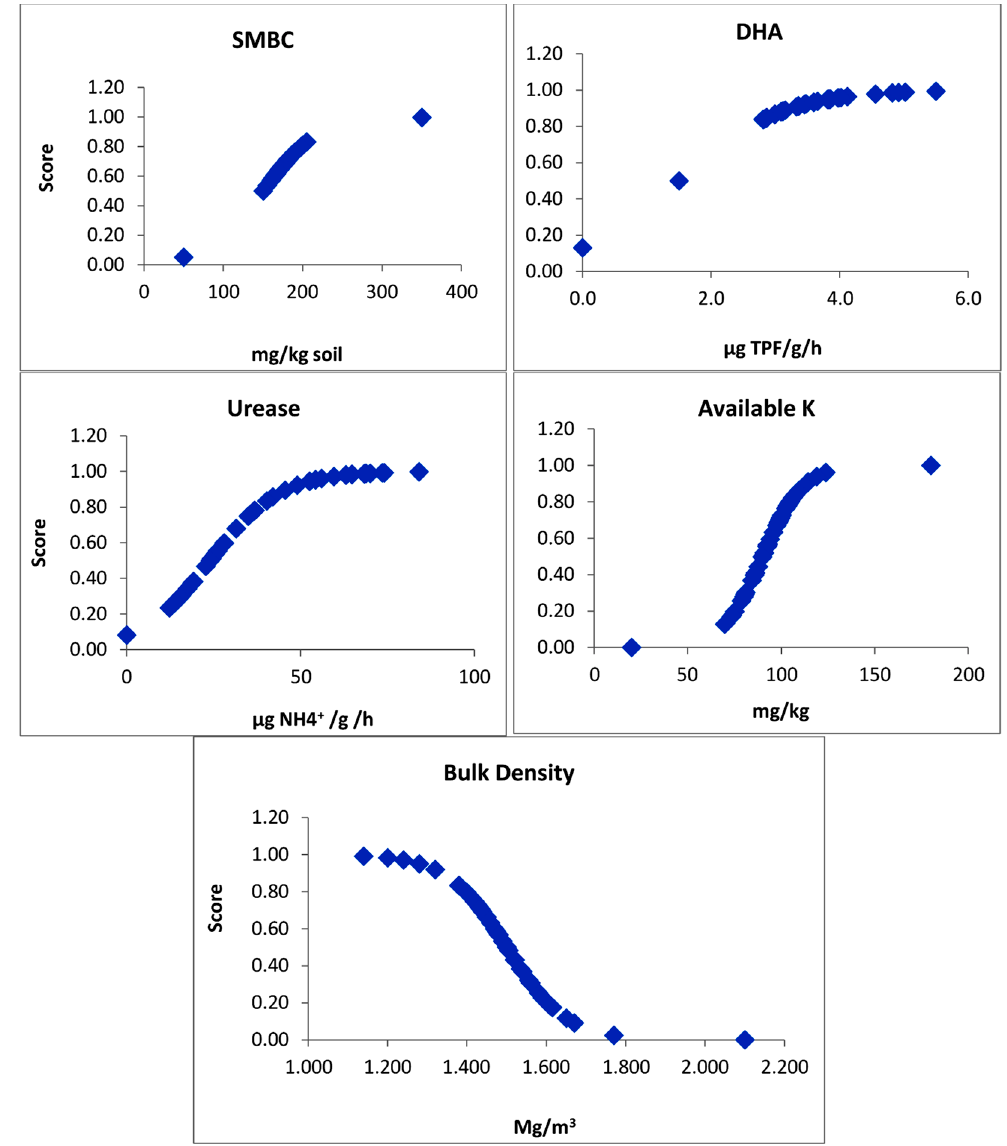
Figure 2. Nonlinear scoring functions for six ninimum data set (MDS)/soil quality indicator. SMBC—soil microbial biomass carbon; DHA—dehydrogenase.